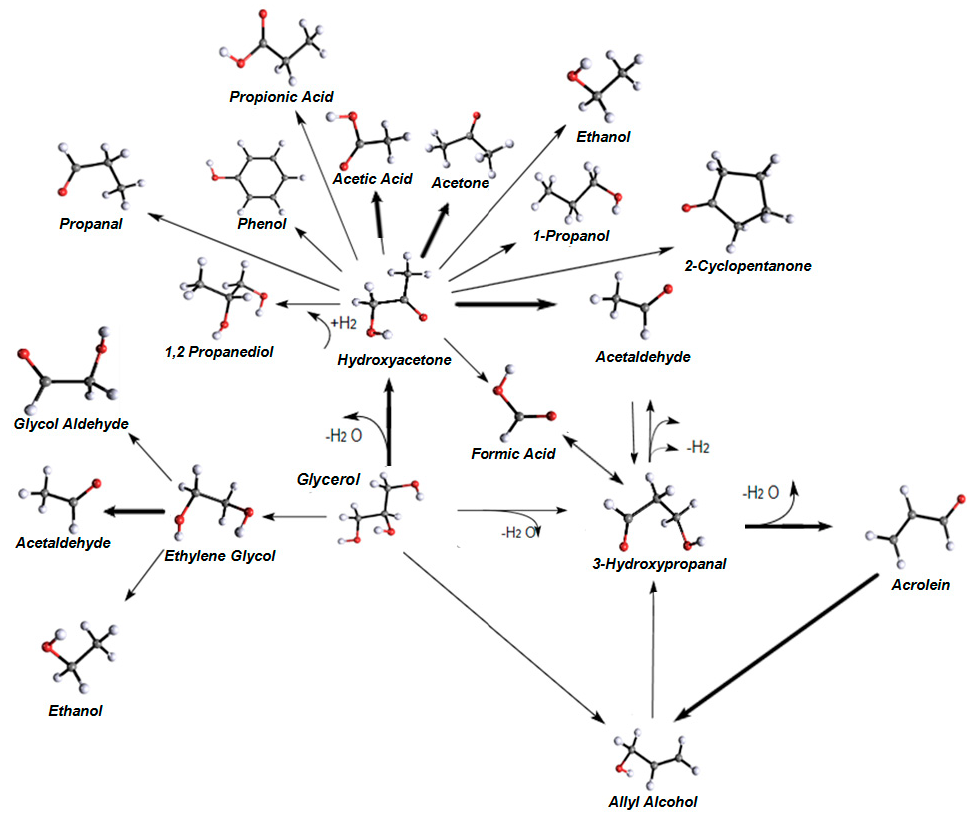
Figure 9. Schematic representation of the plausible reaction pathway for the glycerol steam reforming